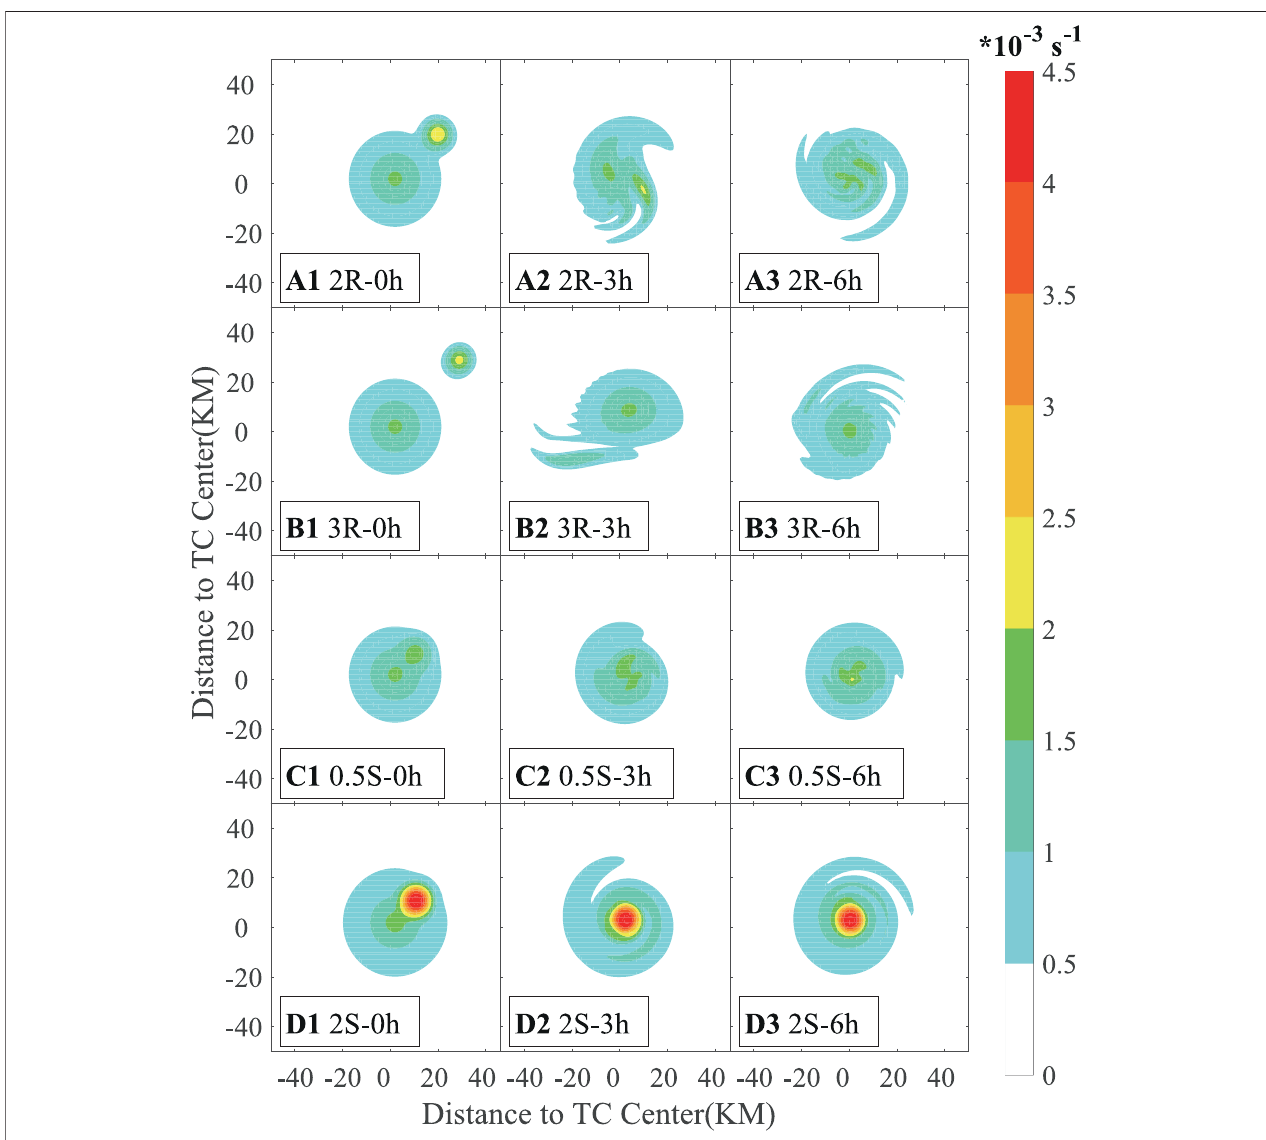
FIGURE 9 | Simulation results of nondivergent barotropic model sensitivity tests. The fi rst, second, and third columns represent the integration times of 0, 3, and 6 h, respectively. Rows (A – D) represent the four situations in which the distance doubles, triples, the mesoscale vortex strength is halved, and the mesoscale vortex is doubled in strength,